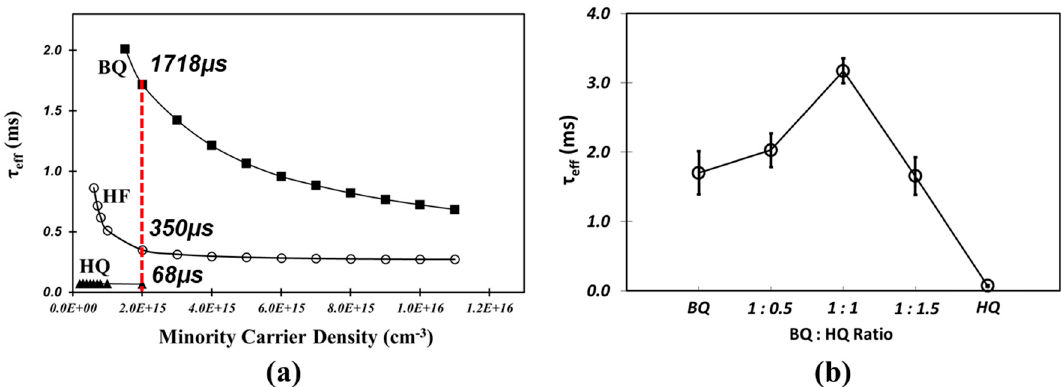
Figure 2. ( a ) Measured τ eff of BQ (solid-square) and HQ (solid-triangle) treated Si compared with HF pre-cleaned-only sample (open-circle); and ( b ) measured τ eff at a minority carrier density